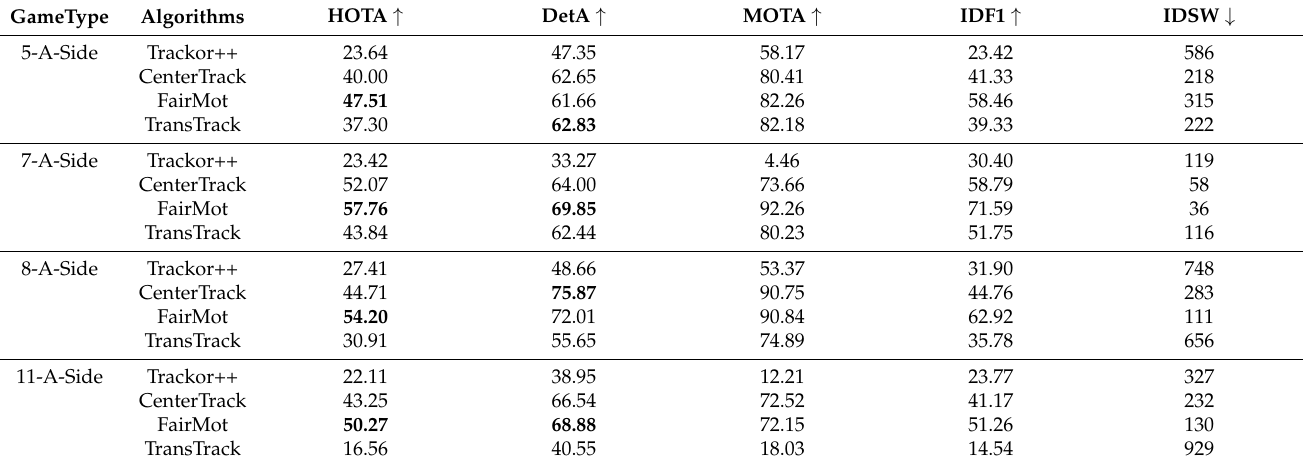
Table 5. Comparison of the candidate methods on